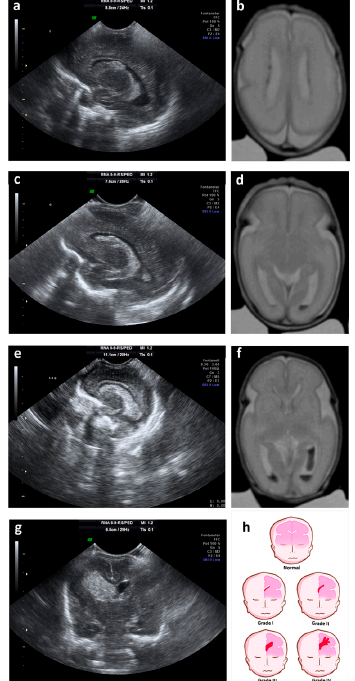
Figure 1. Ultrasound and magnetic resonance imaging (MRI) showing di ff erent grades of GM-IVH. ( a ) Parasagittal cerebral ultrasound through lateral ventricles shows grade I hemorrhage; ( b ) T2- weighted axial MRI shows grade I hemorrhage on both lateral ventricles; ( c ) parasagittal cerebral ultrasound through lateral ventricles shows grade II hemorrhage; ( d ) T2-weighted axial MRI shows grade II hemorrhage on the left lateral ventricle; ( e ) parasagittal cerebral ultrasound through lateral ventricles shows grade III hemorrhage; ( f ) T2-weighted axial MRI shows grade III hemorrhage on the left